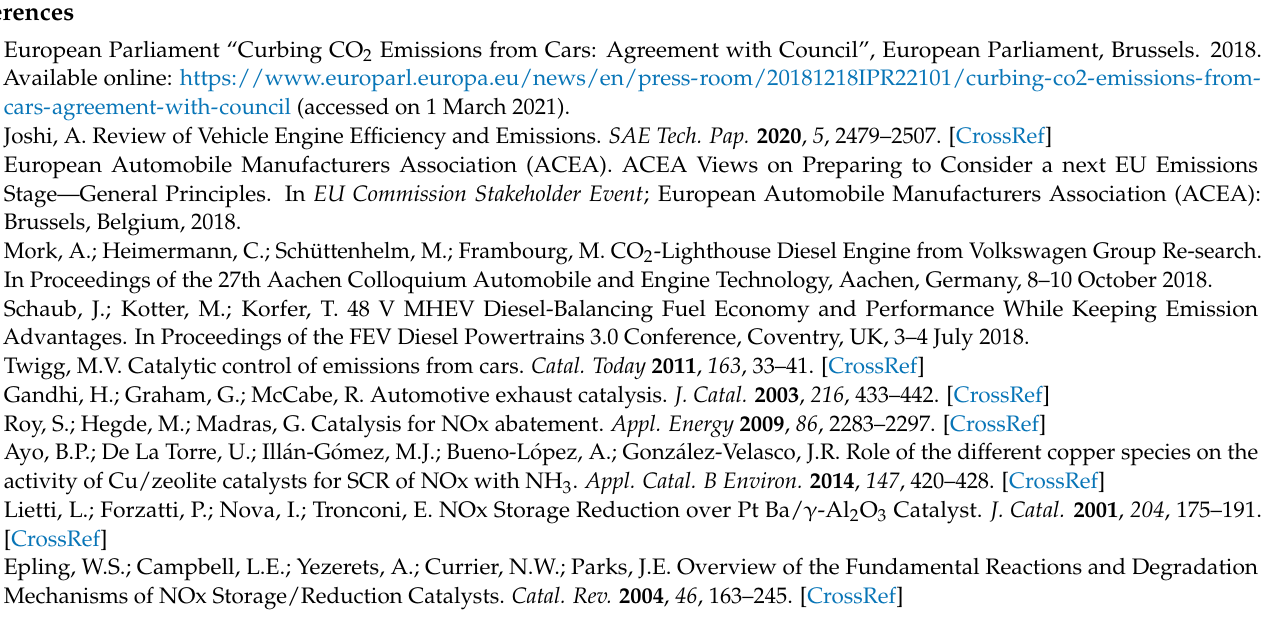
dotted lines) of NOx adsorption step, under 1000 ppm NO + 3% O 2 ( v / v ), at 300 ◦ C, for the catalysts, Figure S3: In situ DRIFT spectra of CZ during NOx adsorption step, at 300 ◦ C, Figure S4: In situ DRIFT spectra of Ba6/CZ during NOx adsorption step, at 300 ◦ C, Table S1: NOx adsorbed amounts obtained from the experiments illustrated on Figures S1 and